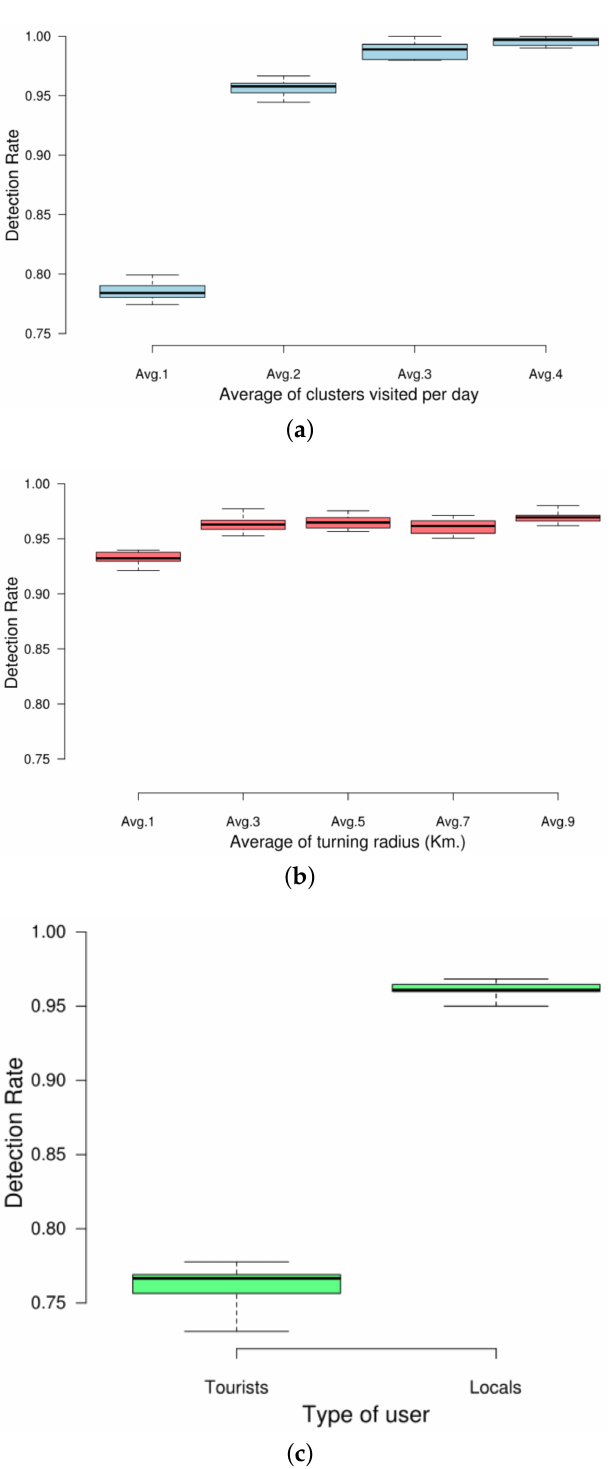
Figure 12. Detection rate of the predictor considering different factors related to users. ( a ) DR considering the avg. number of visited clusters per user per day; ( b ) DR considering the avg. radius of gyration of the target user’s trajectories; ( c ) DR considering tourist and resident users in NY and